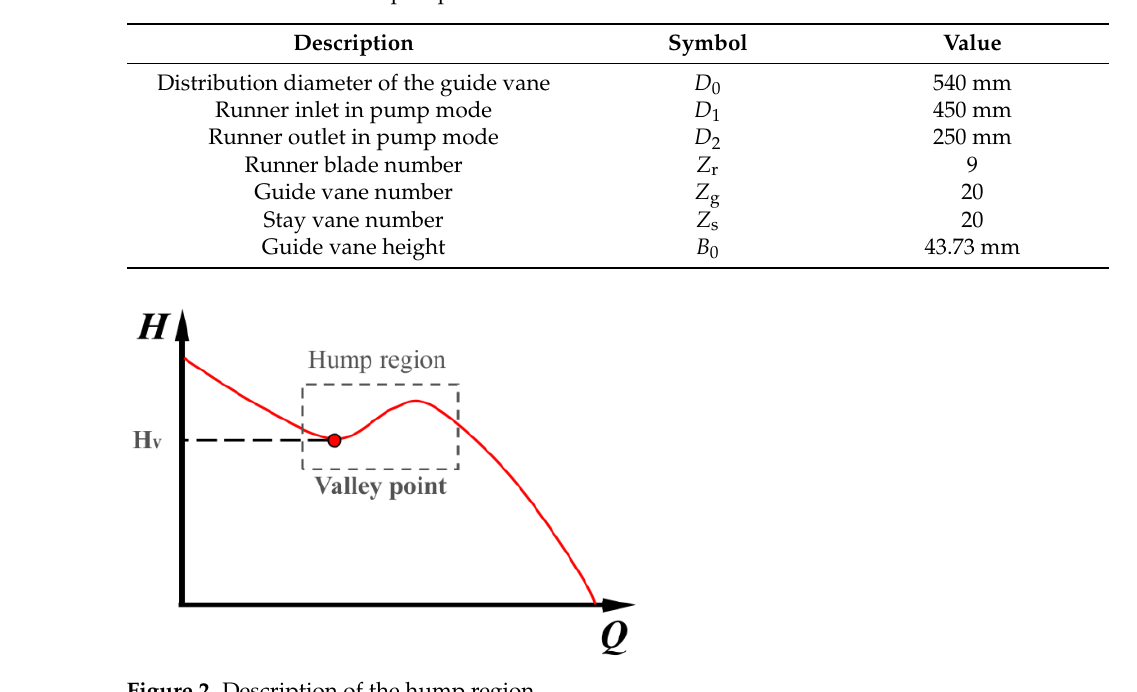
Figure 1. Configuration of the pump turbine model. Table 1. Parameters of the pump turbine.